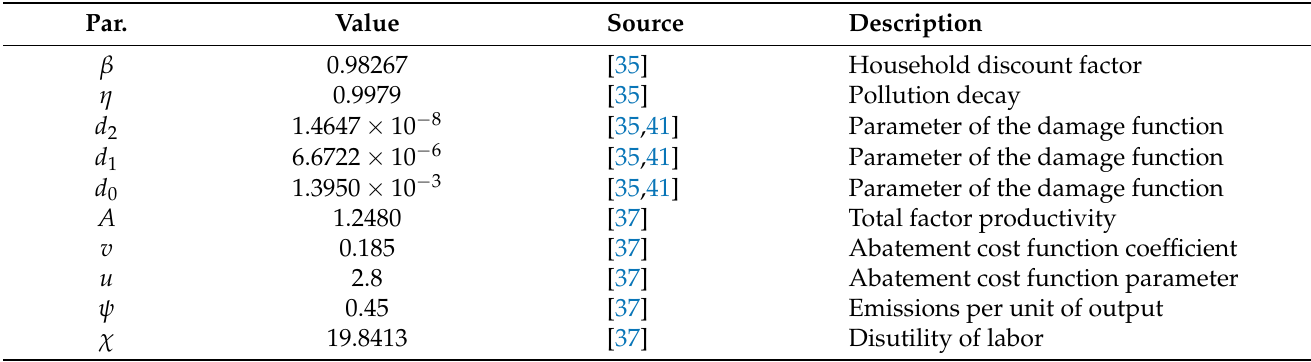
Table 1. Parameter